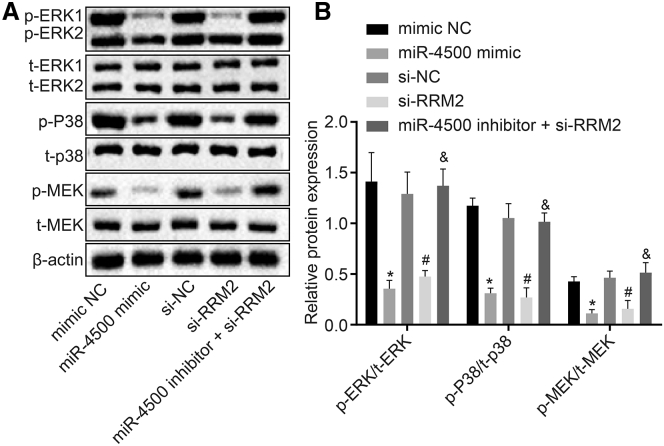
Overexpression of miR-4500 Inhibits the Expression of RRM2 to Inhibit Activation of the MAPK Signaling Pathway(A) The protein expressions of p-ERK/t-ERK, p-p38/t-p38 and p-MEK/t-MEK detected by Western blot. (B) Comparison of relative protein expression of p-ERK/t-ERK, p-p38/t-p38, and p-MEK/t-MEK in each group. *, #, and &p < 0.05 versus the mimic NC group, si-NC group, and si-RRM2 group, respectively. The data comparisons were analyzed by one-way ANOVA, and the experiment was repeated three times independently.